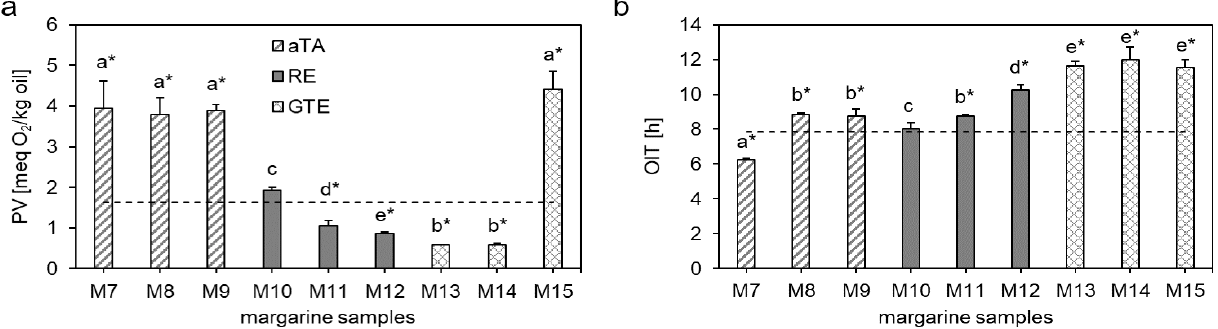
Figure 3. Influence of different antioxidants on the oxidative stability of margarine determined by the peroxide value ( a ) and oxidation induction time ( b ). All margarine samples were produced using E1 in the commonly applied concentration. The influence of DL- α -tocopheryl acetate in commonly applied concentration, 20% lower concentration and 20% higher concentration was analyzed in samples M7–M9, respectively. The influence of rosemary extract in commonly applied concentration, 20% lower concentration and 20% higher concentration was analyzed in samples M10–M12, respectively and the influence of green tea extract in commonly applied concentration, 20% lower concentration and 20% higher concentration was analyzed in samples M13–M15, respectively. Data are depicted as mean + SD (n = 4). Statistically significant differences between the margarine samples are indicated with different lower-case letters (one-way ANOVA, Holm–Sidak, p < 0.05). The asterisks show a significant difference to the control. M1 was used as control (dashed line, 1.64 meq O 2 /kg oil ( a ), 7.86 h ( b )).